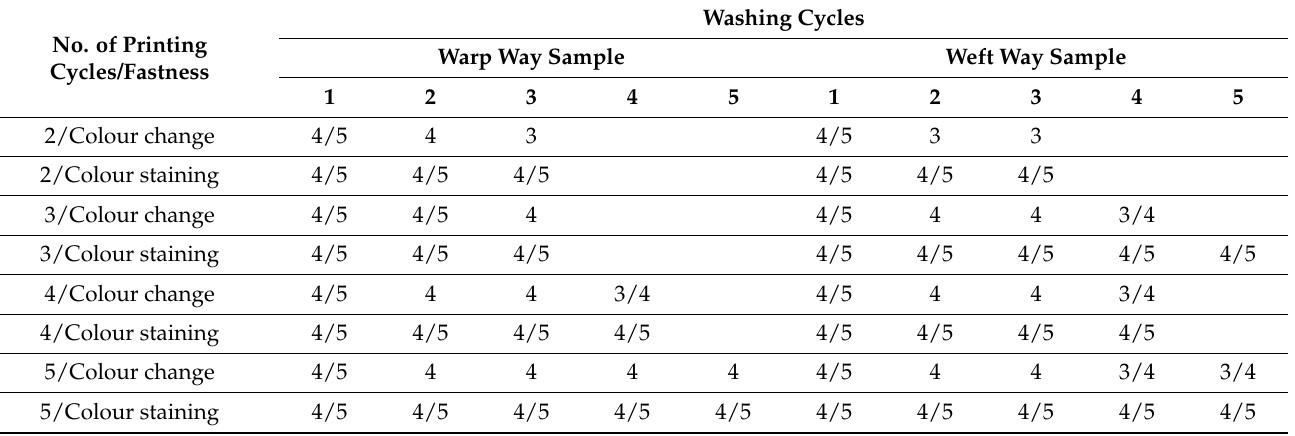
Table 1. Colour fastness of the metallised textiles printed with the Cu–Ag NP catalyst at different numbers of printing cycles and